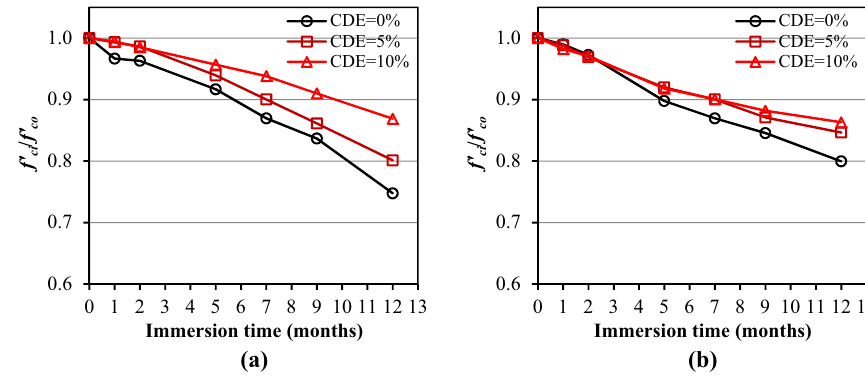
Figure 15: Degradation of compressive strength due to ( a ) NaCl and ( b ) Na 2 SO 4